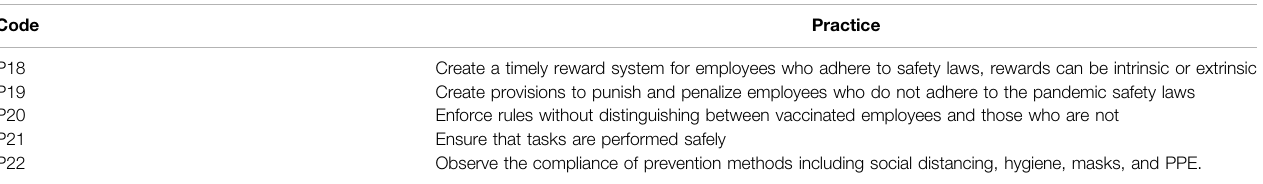
TABLE 5 | Recommended practices to ensure